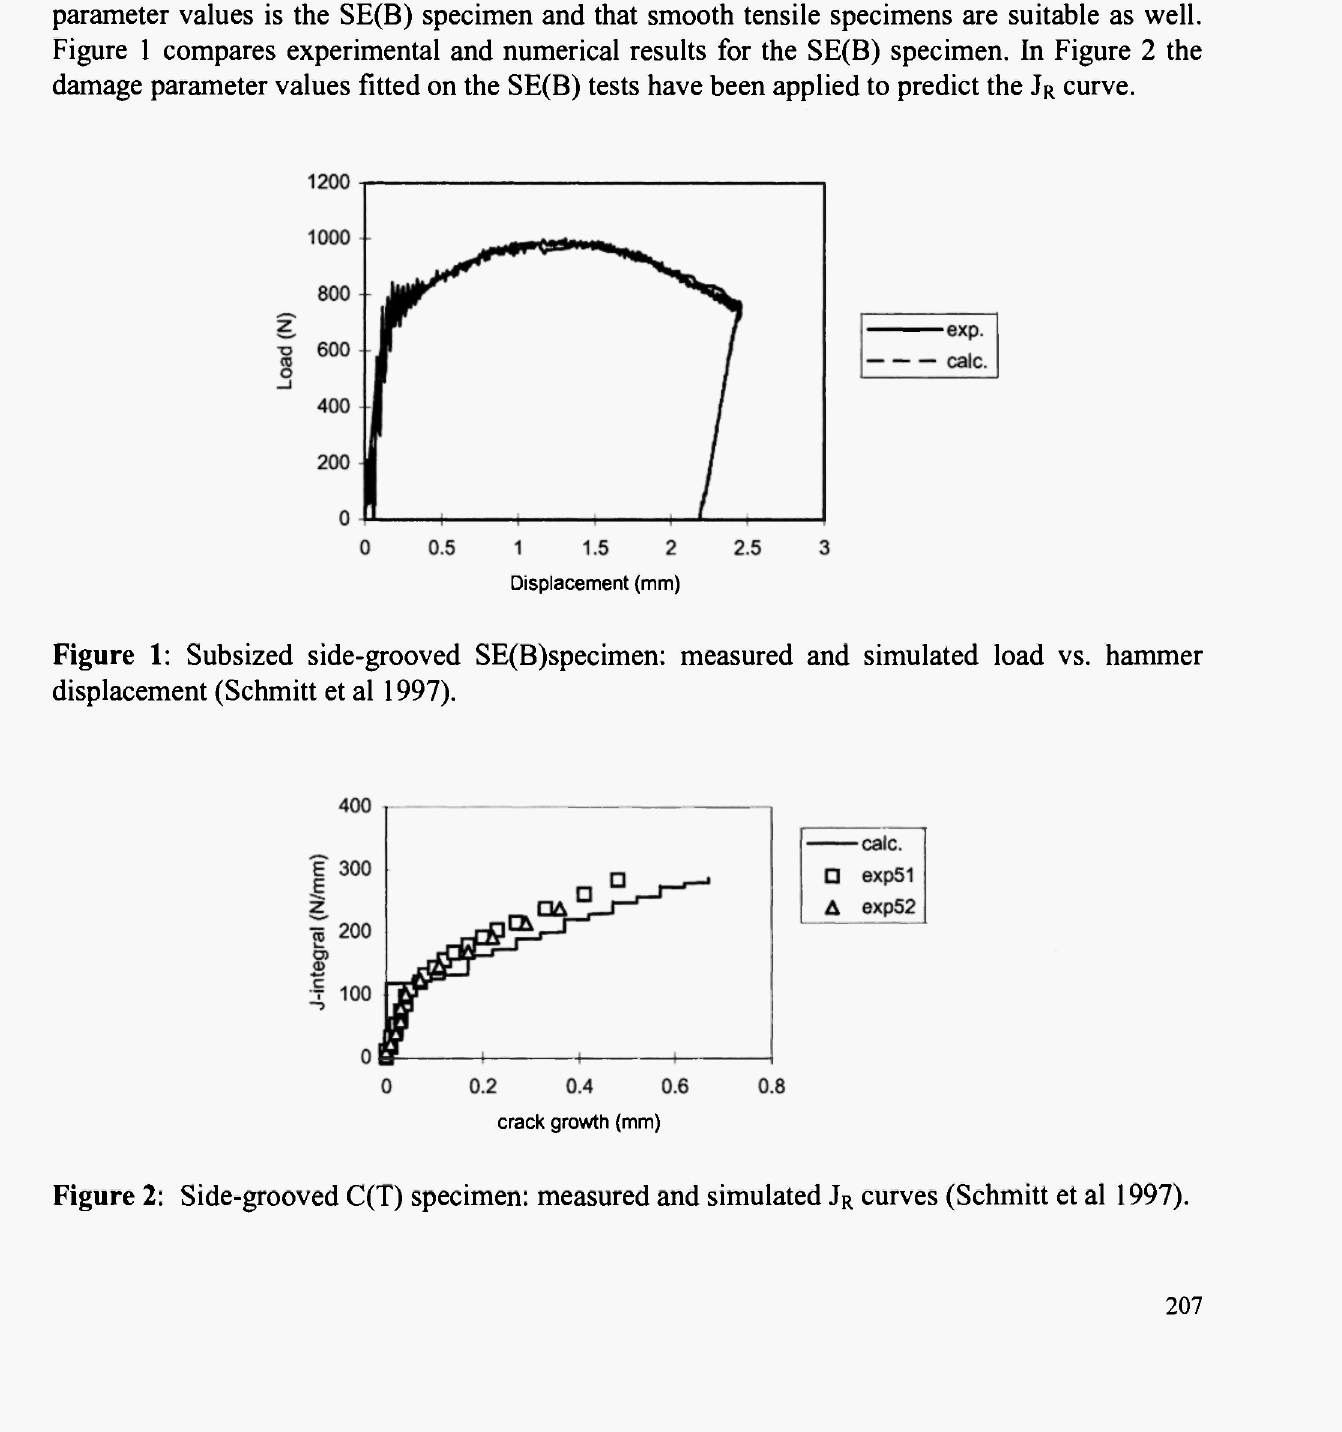
curves (Schmitt et al 1 9 9 7 R